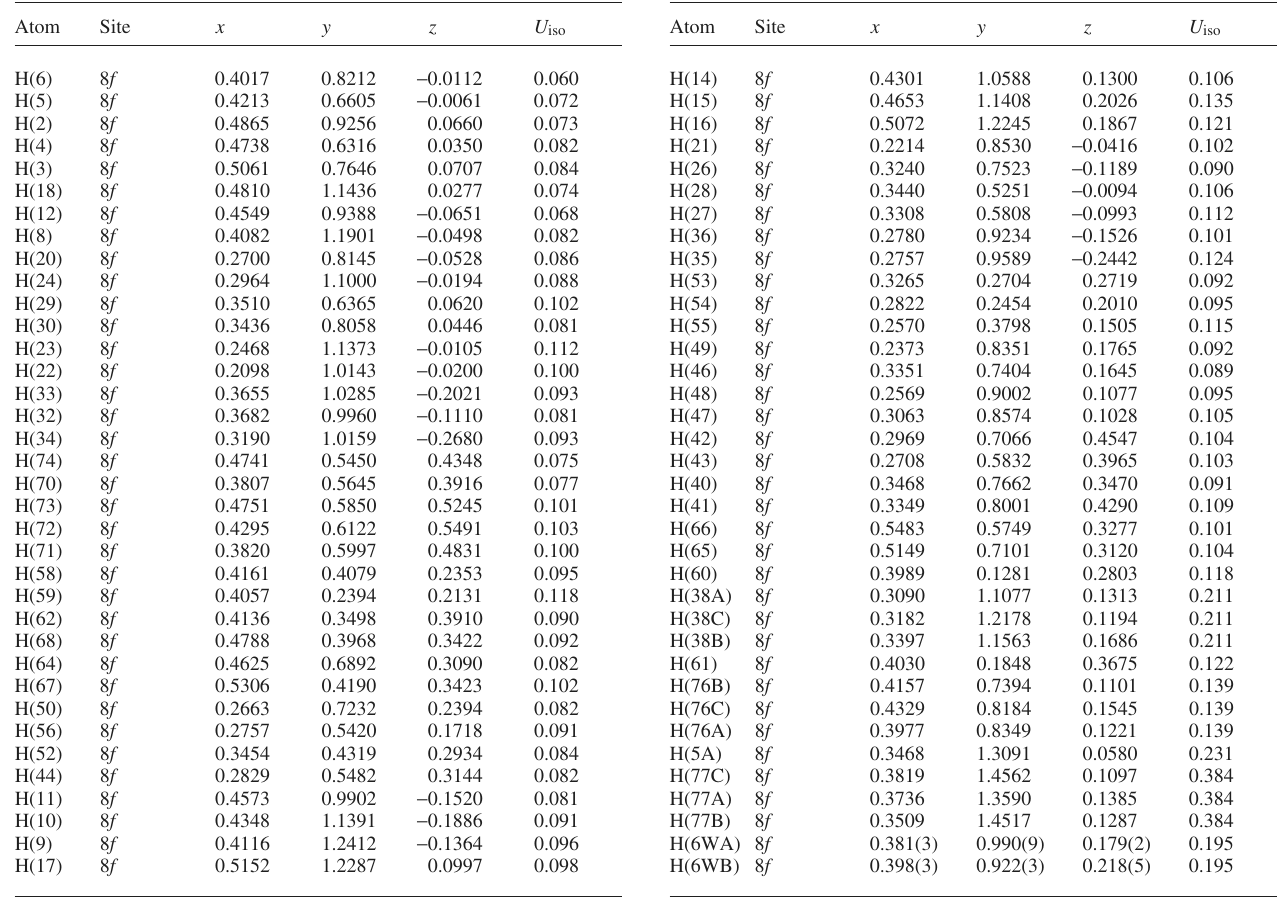
Table 2. Atomic coordinates and displacement parameters (in Å 2 )